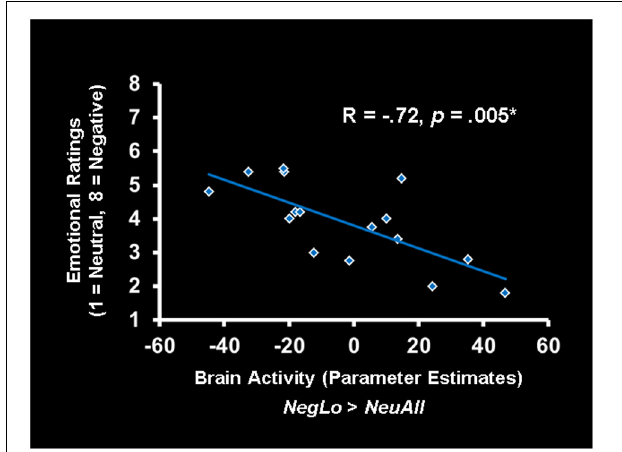
FIGURE 3 | Activity in the ACC was linked to reduced ratings for low-arousing stimuli in older adults. In older adults, increased activity in the ventral anterior cingulate cortex (vACC)/ventro-medial prefrontal cortex (vmPFC) correlated negatively with the ratings for low arousing negative stimuli. The scatterplot is based on the parameter estimates corresponding to the peak voxel in the area of vACC/vmPFC showing negative correlation with the behavioral ratings. NegLo, Negative Low Arousal; NeuAll, Neutral